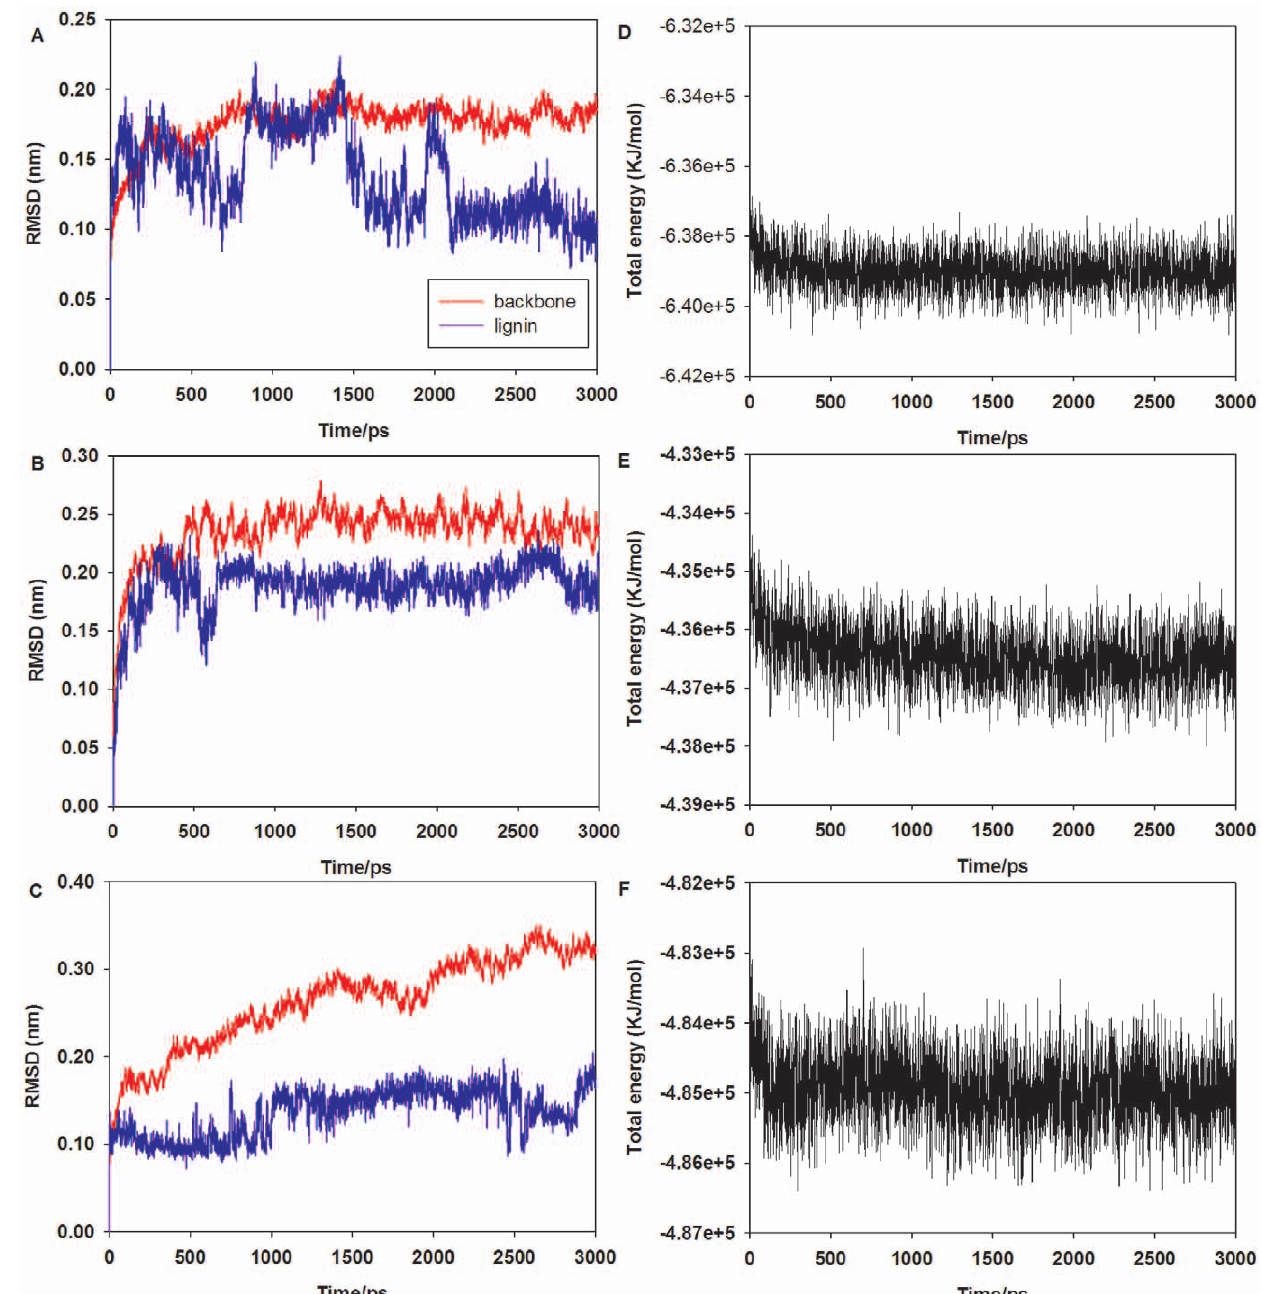
Figure 4. RMSD obtained during 3000 ps MD simulations for the backbones (red lines) and lignin (blue lines) from the corresponding starting structures of Lac-lignin (A), LiP-lignin (B) and MnP-lignin (C) complexes as a function of the simulation time, and plots of total energy vs. simulation time (D, Lac-lignin system; E, LiP-lignin system; and F, MnP-lignin system).